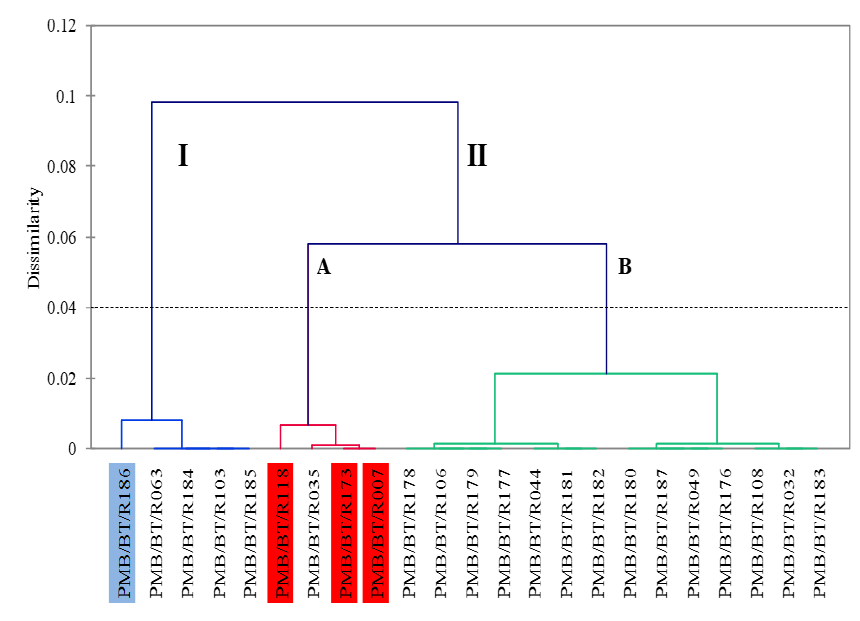
Figure 7 Dendrogram showing the similarity of different cultivars on the basis of their response to 0.8 mg/L